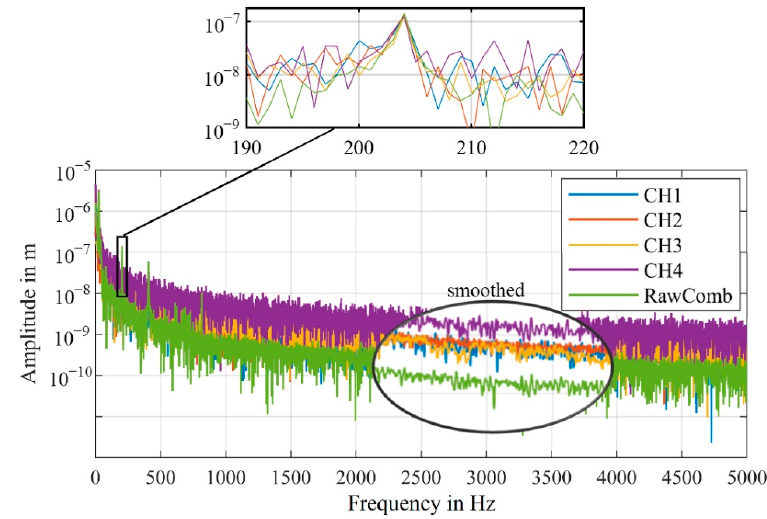
Figure 16. Comparison of the frequency spectra of the four channels CH1–CH4 and combined signal, one section of the spectra is shown smoothed for better visualization; (RBW = 1 Hz).